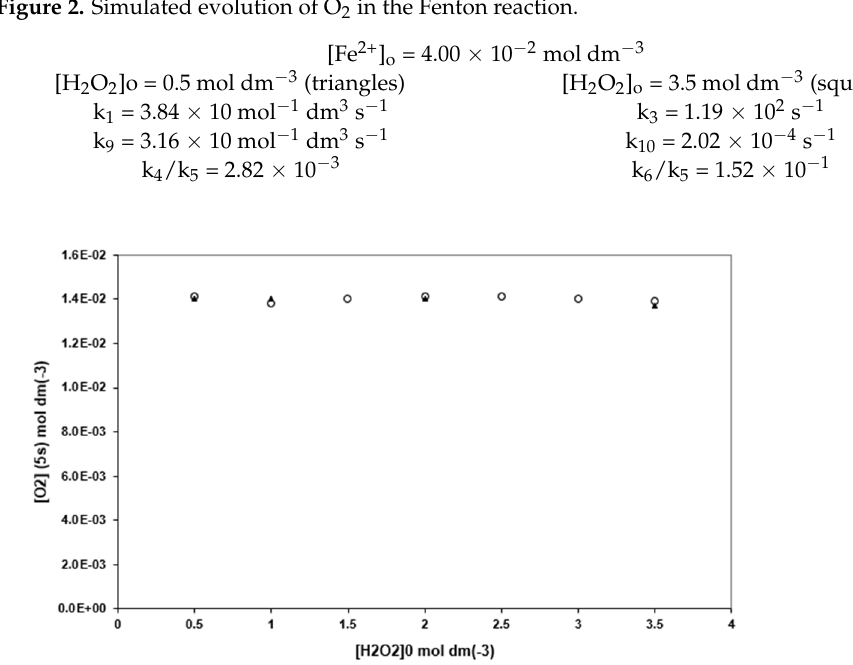
Figure 2. Simulated evolution of O 2 in the Fenton reaction.